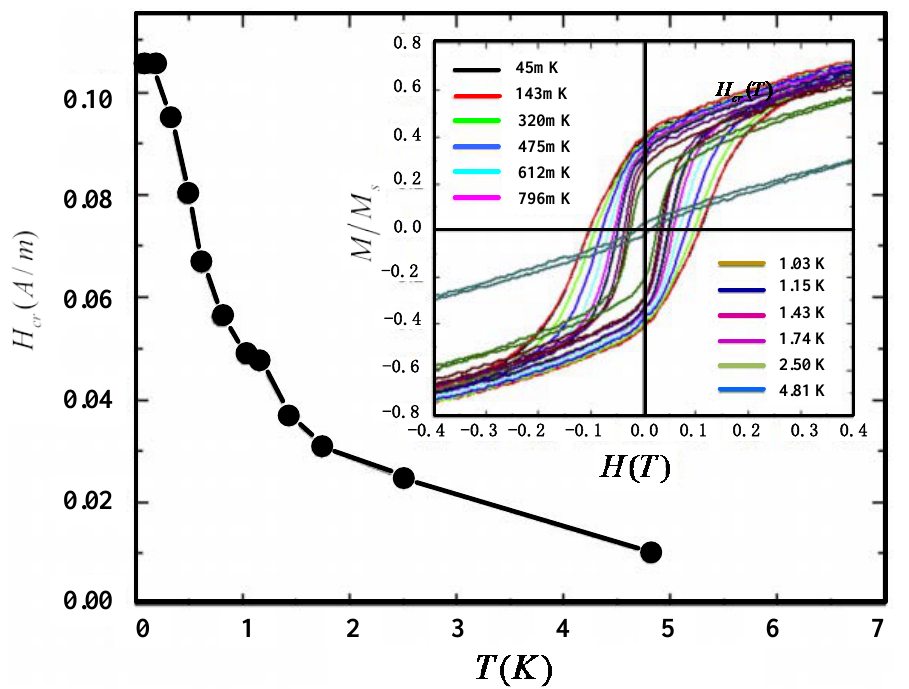
Figure 1. Temperature-dependence hysteresis and coercive force for permanent magnet [Ru 2 (O 2 CMe) 4 ] 3 [Fe(CN) 6 ]. The main panel shows that the coercive force decreases with temperature decreasing. The coercive force decreases slowly with increasing temperature, but abruptly decays in the vicinity of the transition temperature. The inset shows the magnetic hysteresis loops between 40 mK and 4.8 K. The smallest hysteresis occurs at highest temperature 4.8 K, which then grows with decreasing temperature until saturating below 143 mK.